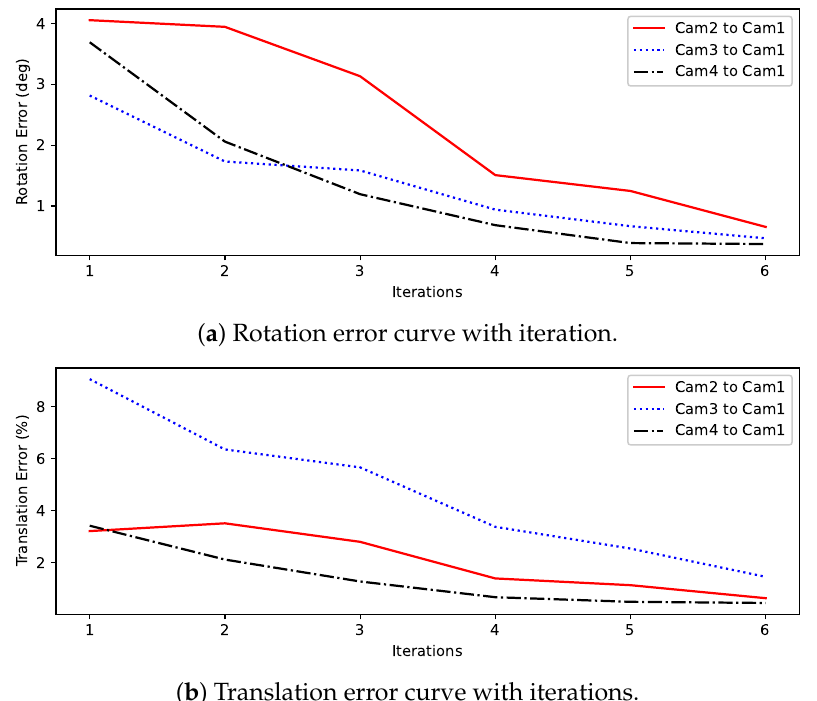
Figure 5. The translation error and rotation error curves with iterations.